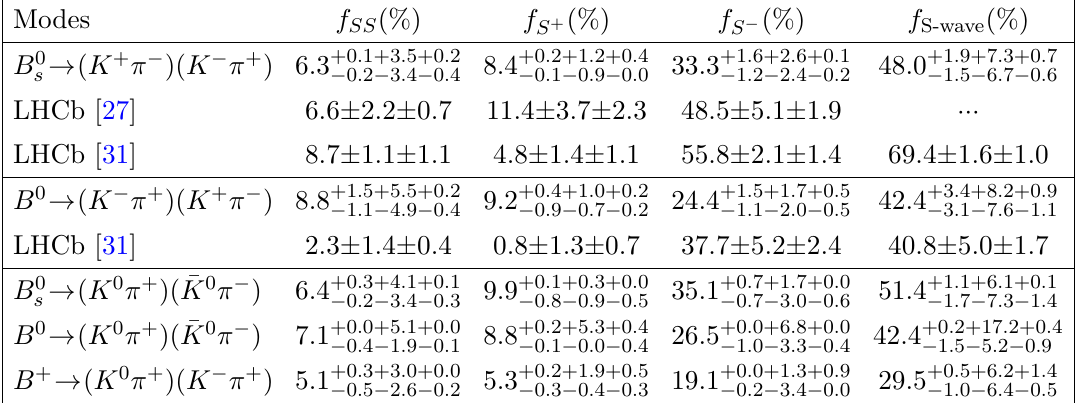
Table 2 . S -wave fractions in the B window of 150 MeV around the K ∗ (892) resonance. The data corresponding to the same invariant mass window are taken from [27, 31], where the first uncertainty is statistical and the second is